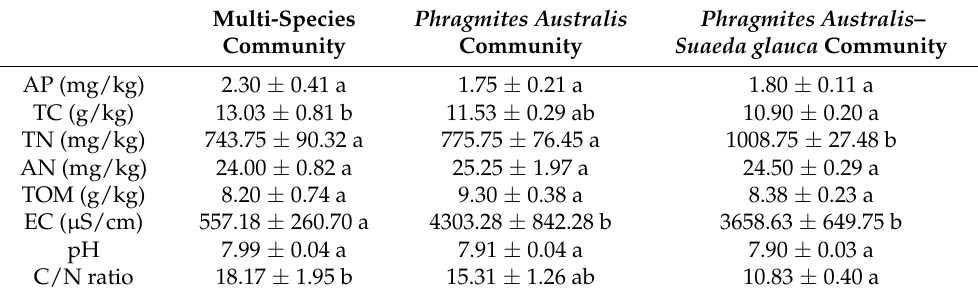
Table 2. Soil physical and chemical parameters of the three dominant vegetation communities in the